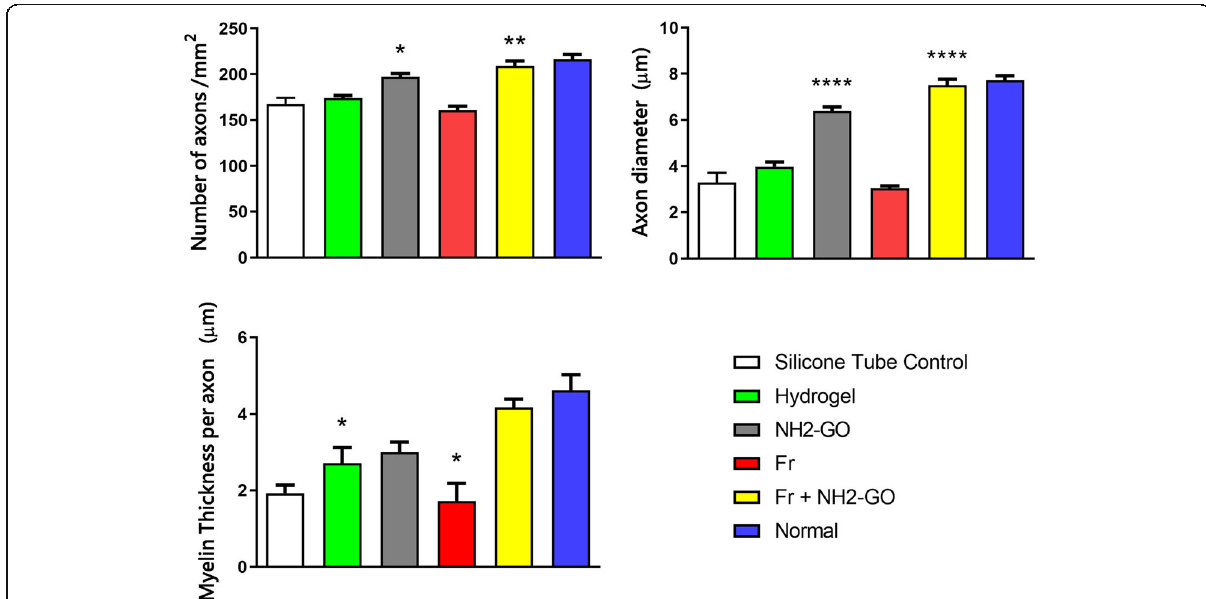
Fig. 4 Quantification of nerve regeneration distal to the axotomy site. Axon count, mean diameter, and myelin thickness parameters for all groups were analyzed with one-way ANOVA with Holm-Sidak multiple comparison test used for p value output. The data are presented as mean ± standard error of the mean (SEM). p values reported above for interventional groups were based on comparison with the hydrogel control group. The results of hydrogel group itself were compared to those of silicone tube control group (*=0.005< p value<0.05, **= 0.0005< p value< 0.005, ***= 0.0001< p value<0.0005, ****= p value<0.0001). Increased axon count was noticeable both in NH2-GO ( p value= 0.0252) and Fr + NH2- GO ( p value=0.0008) groups. Axon diameter was also significantly increased in these groups and reaching similar levels to normal in Fr + NH2-GO group. Moreover, the use of hydrogel improved myelin regeneration ( p value=0.0189) while graphene oxide failed to further increase this effect. Fr did not prove effective in promoting nerve regeneration and was detrimental to myelin